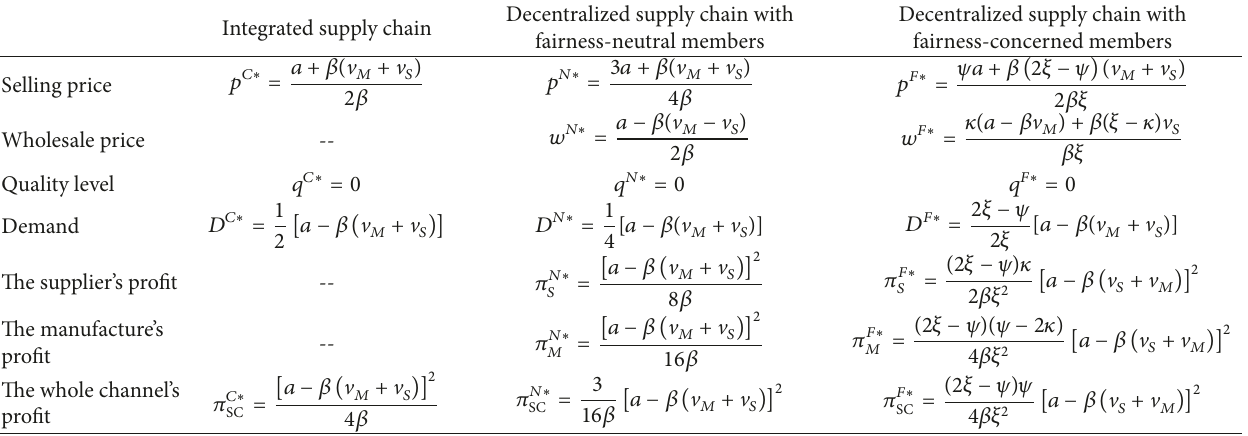
Table 1: The equilibrium solutions under different scenarios when 𝑇 < 0 .